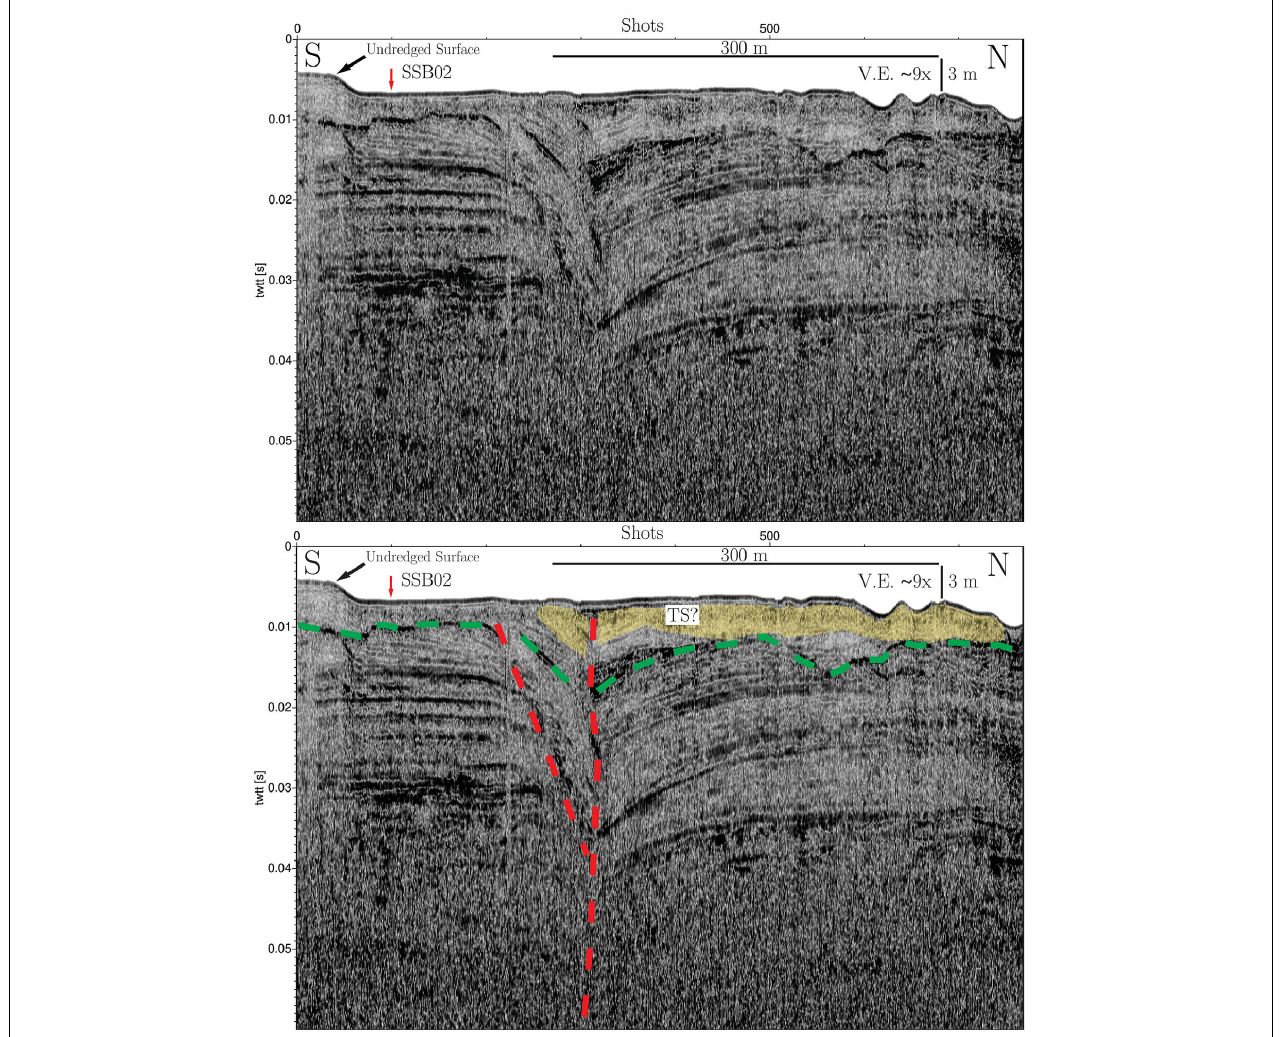
FIGURE 11 | Chirp profile SSB05 from the Crown Cove area showing displacement associated with western pop-up structure fault. Red dashed lines are faults. Green dashed horizon is the interpreted subaerially exposed surface from the Last Glacial Maximum sea level low-stand. Yellow unit is the interpreted estuarine/marine high-stand deposit, with the base representing the transgressive / inundation surface (TS, Transgressive Surface). Red arrow marks the location of the east-west oriented SSB02 profile ( Figure 10 ). See Supplementary Figure 5a for